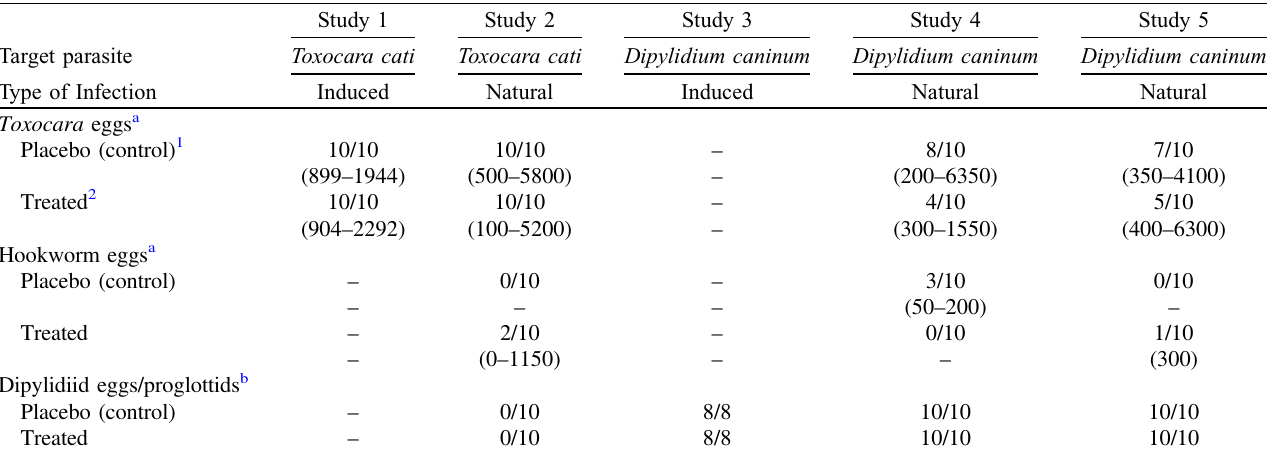
Table 2. Results of pre-treatment fecal